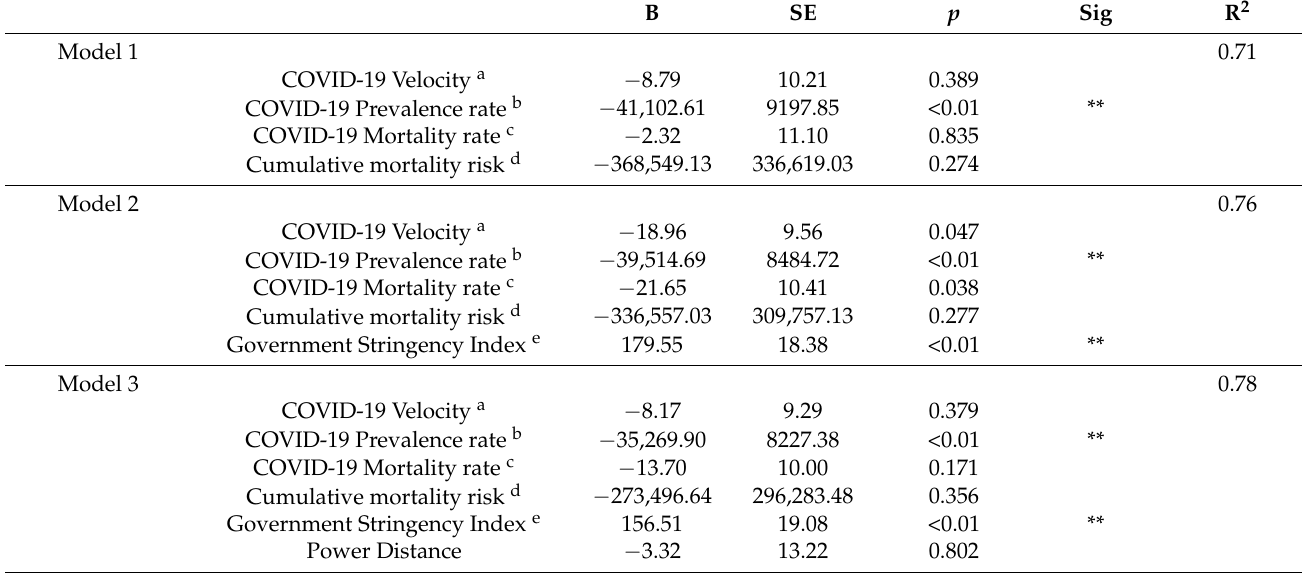
Table 1. Presents three mixed effect regression models with prevalence of collocates as the outcome, with fatalities, cases, and GSI as